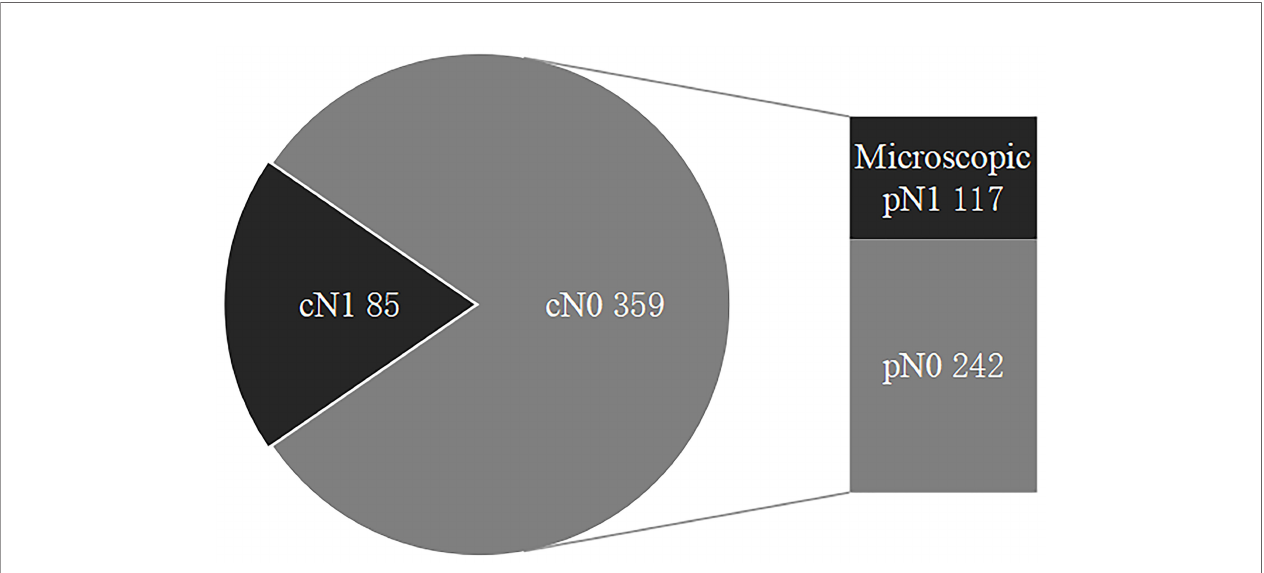
FIGURE 1 | The status of regional lymph nodes in papillary thyroid carcinoma. LNMs include cN1 and microscopic pN1, and cN0 are comprised of microscopic pN1 and pN0. LNMs, lymph node metastases; cN1, clinical N1; Microscopic pN1, microscopic pathological N1; cN0, clinical N0; pN0, pathological N0.